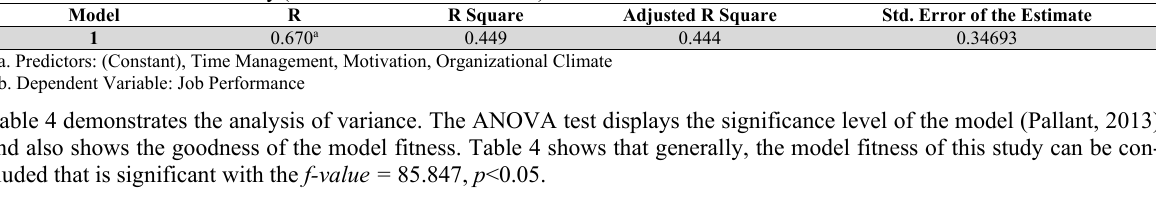
The Result of Model Summary (Coefficient Determination)